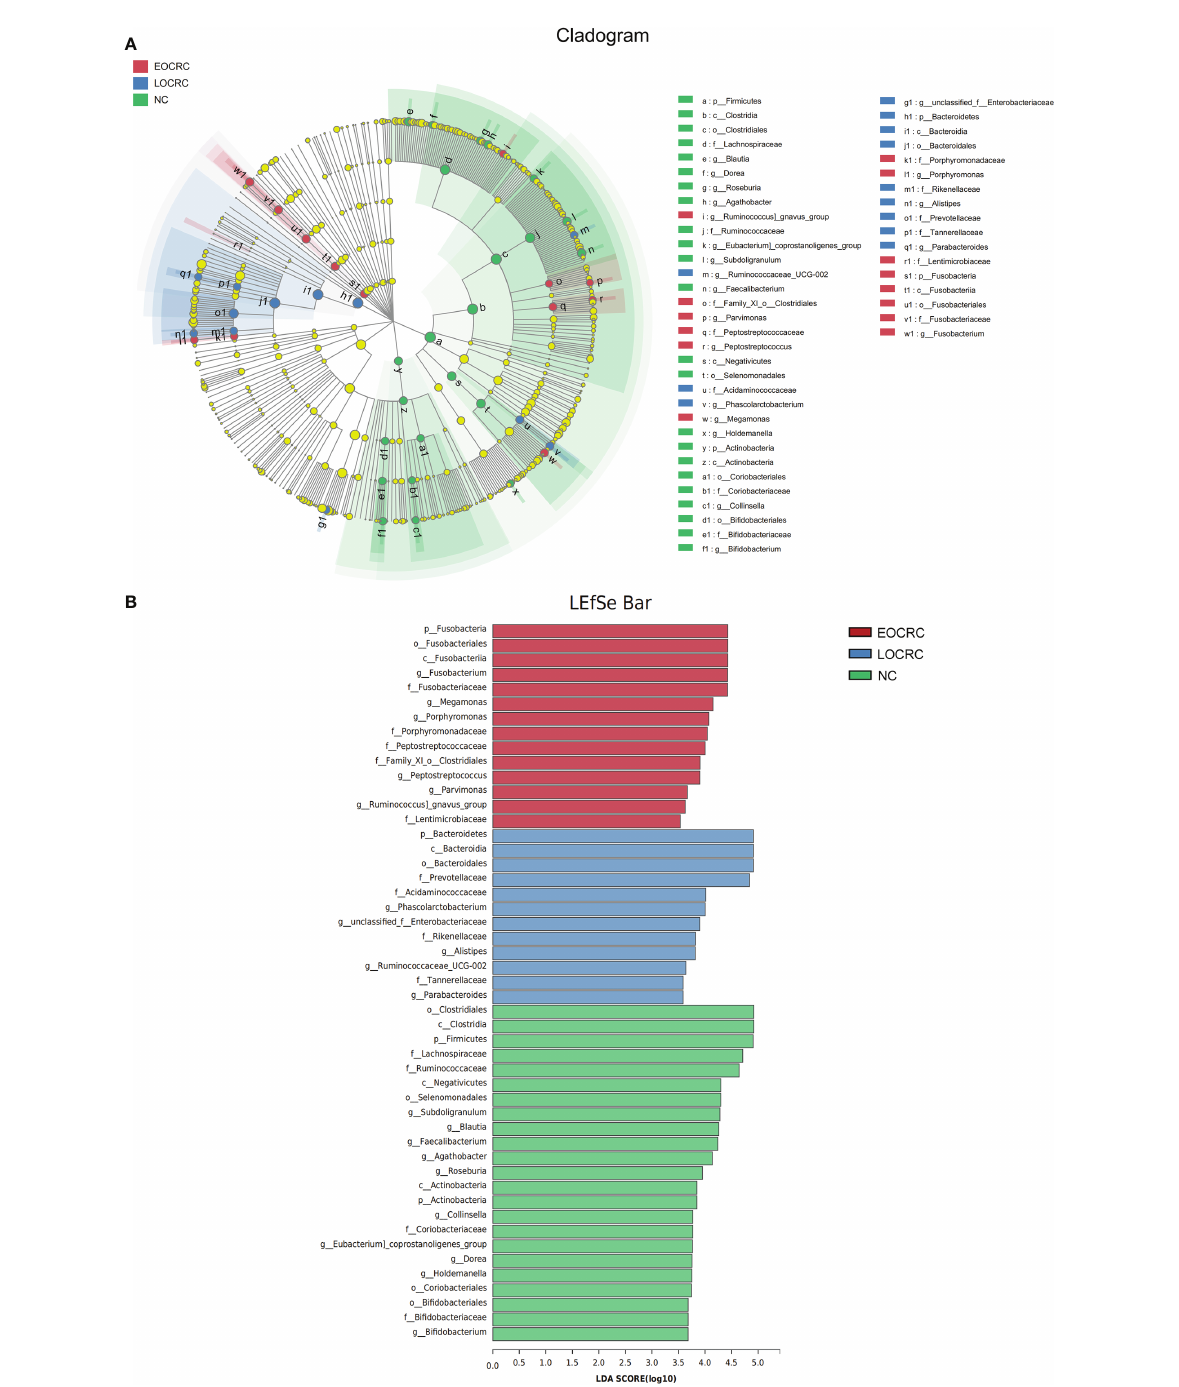
FIGURE 3 LEfSe algorithms were performed on the three groups. (A) : Cladogram measured from the LEfSe analysis. (B) : The LDA scores were obtained by linear regression analysis (LDA). The threshold for the linear discriminant analysis score was set at 3.5. The larger the LDA score, the greater the difference between the three